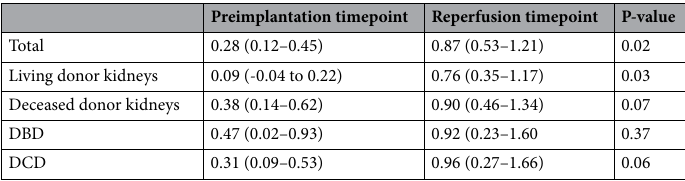
Table 2. Number of microthrombi/mm 2 per group.